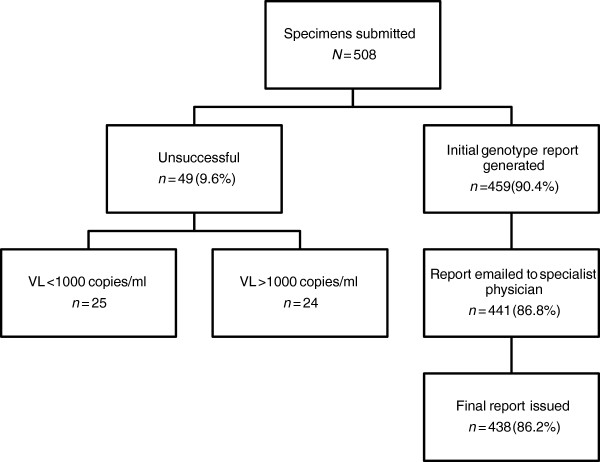
Flow diagram of processes involved in production of final resistance report.